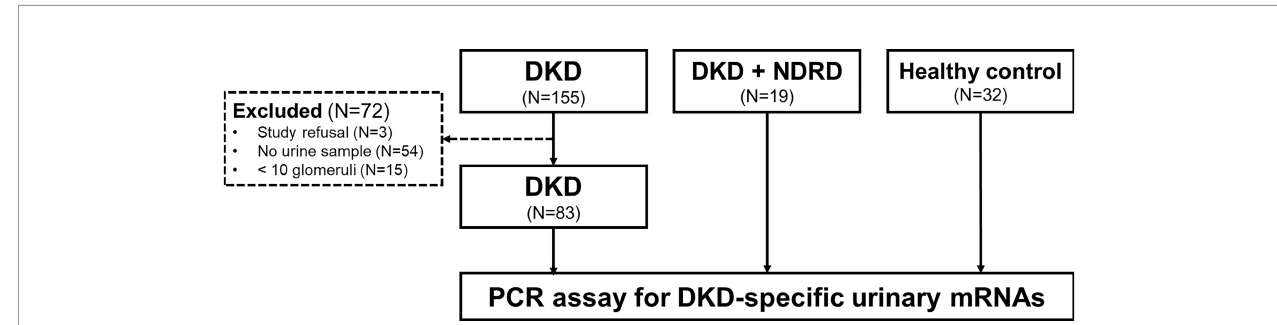
FIGURE 1 | Flowchart of participant selection. We fi rst screened 155 patients with diabetic kidney disease (DKD) whose diagnoses were con fi rmed by kidney biopsy. Among these, 83 patients with availability of urine samples were enrolled in this study. We also recruited 19 patients exhibiting both DKD and non-diabetic renal disease (NDRD) and 32 healthy individuals as control groups. Urinary cell pellets from the participants were collected and analyzed for measurement of the levels of DKD-speci fi c mRNA candidates selected based on the metanalysis of the public GEO repository. DKD, diabetic kidney disease; NDRD, non-diabetic renal disease; PCR, polymerase chain